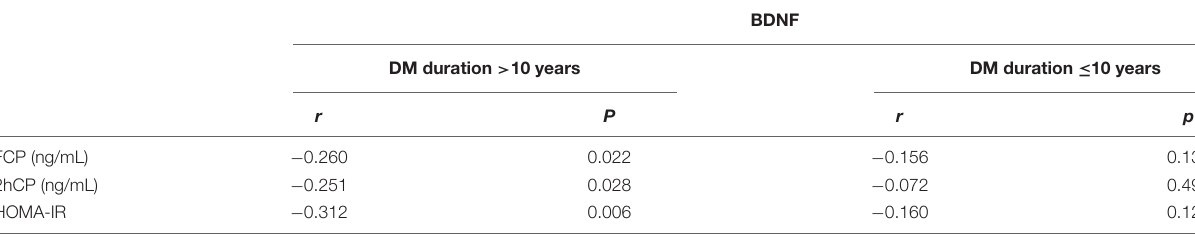
TABLE 4 | Relationship between BDNF and clinical indicators in T2DM patients with different durations.